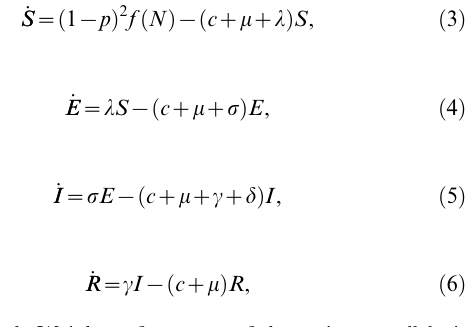
Table 1. Table of model parameters employed.